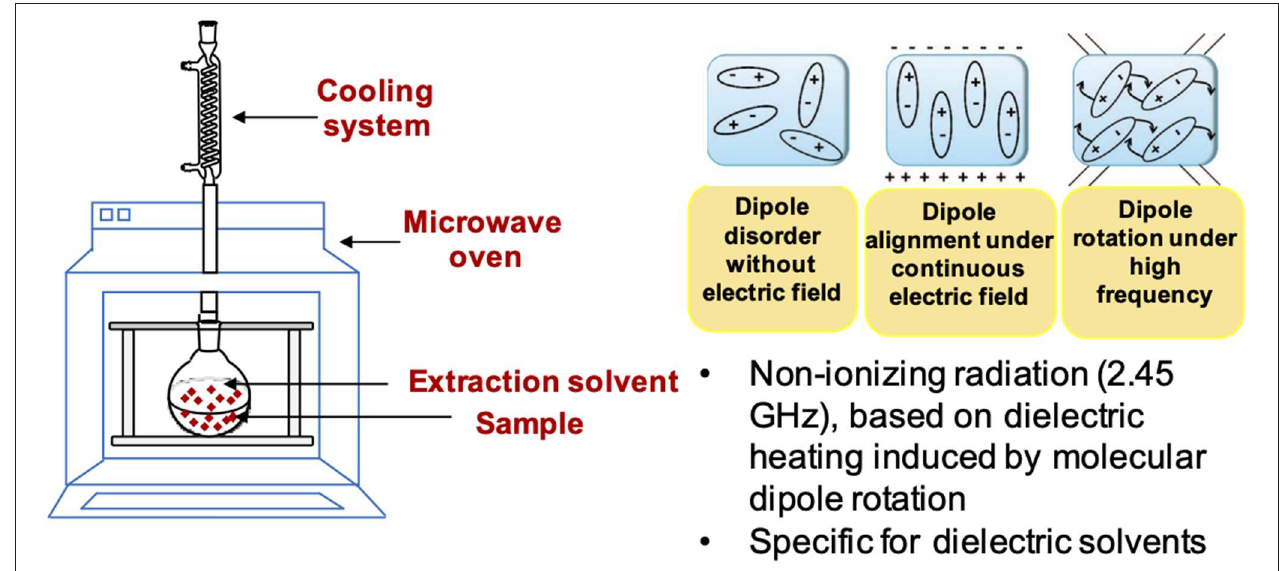
FIGURE 3 | Schematic representation of MAE equipment and characteristics.